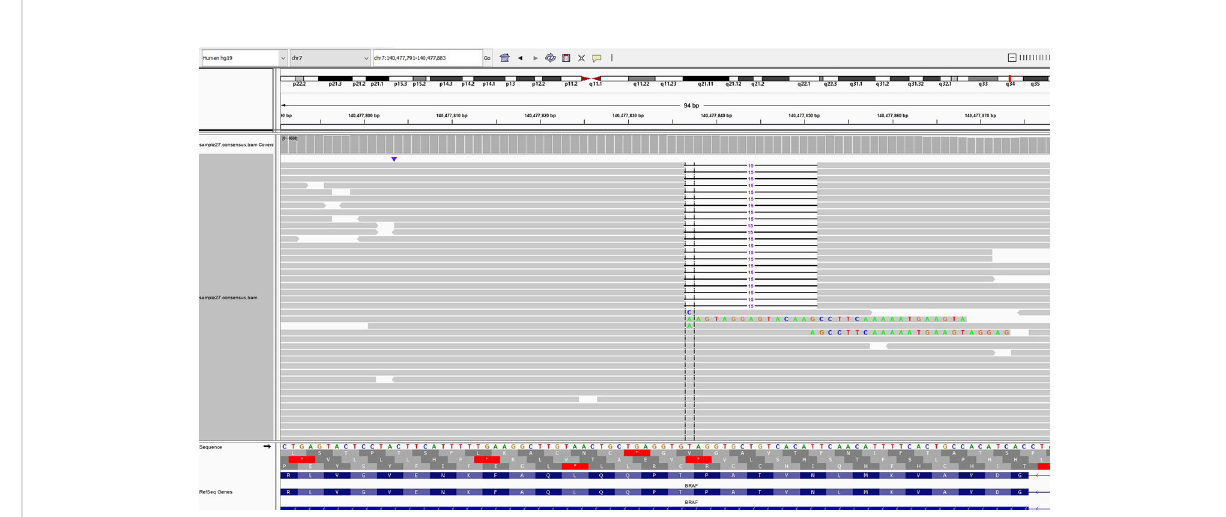
FIGURE 1 Next-generation sequencing of the liquid biopsy specimen revealed a NVTAP (N486_P490) deletion. The data was provided by the Department of Research and Development, Foundation Medicine Inc.